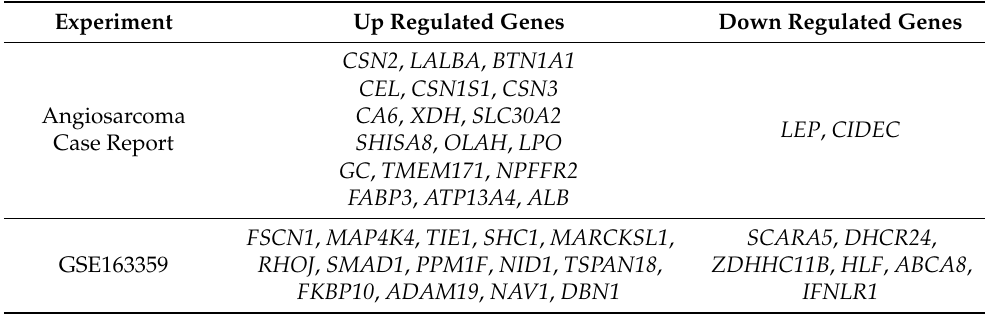
Table 3. The top 20 genes of the differential expression signature found for: angiosarcoma case report compared to adjacent healthy tissue and the public dataset that corresponded to 13 human angiosarcoma tissues and 6 non-malignant tissues used as non-tumor controls.